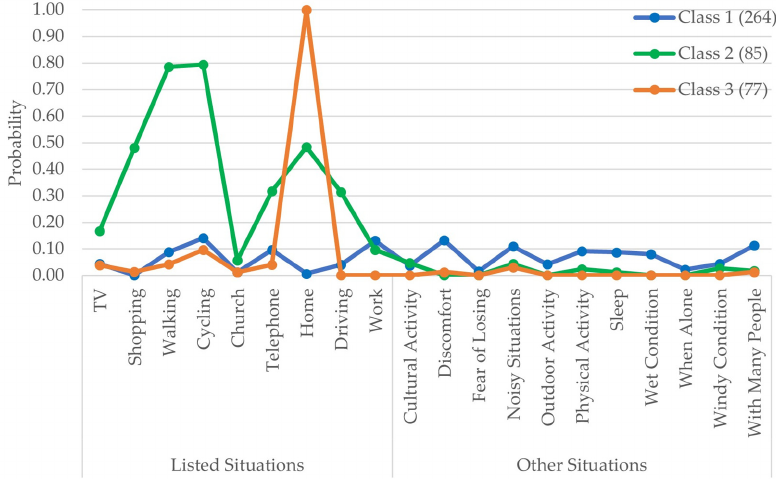
Figure 3. The item response probabilities for situations where HA users always took o ff their HAs with respect to each latent class. The legend also shows the class proportions. The situations listed in the questions are in the “listed situation” group, and the “other situation” group are situations that are derived from the theme analysis of the free-hand text responses delivered by the HA